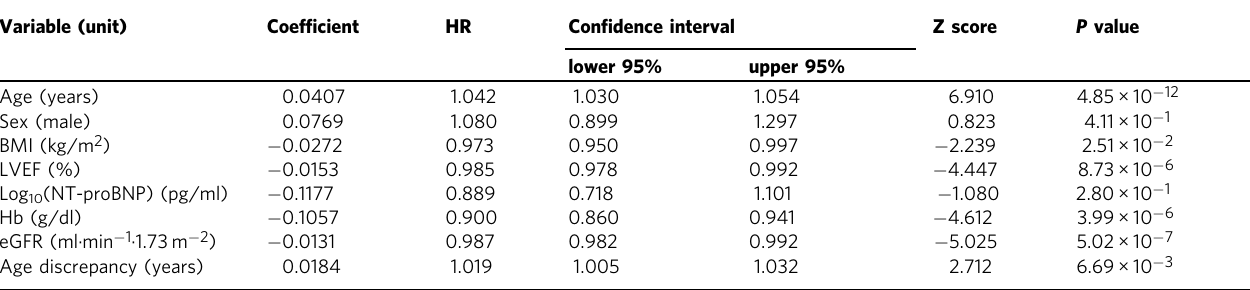
Coef fi cients of the Cox proportional hazards model for the primary endpoint in patients with HF. HR hazardratio, BMI bodymassindex, LVEF leftventricularejectionfraction, Hb hemoglobin, eGFR estimatedglomerular fi ltrationrate, agediscrepancy ,differencebetweentheX-rayageandchronological age (X-ray age − chronological